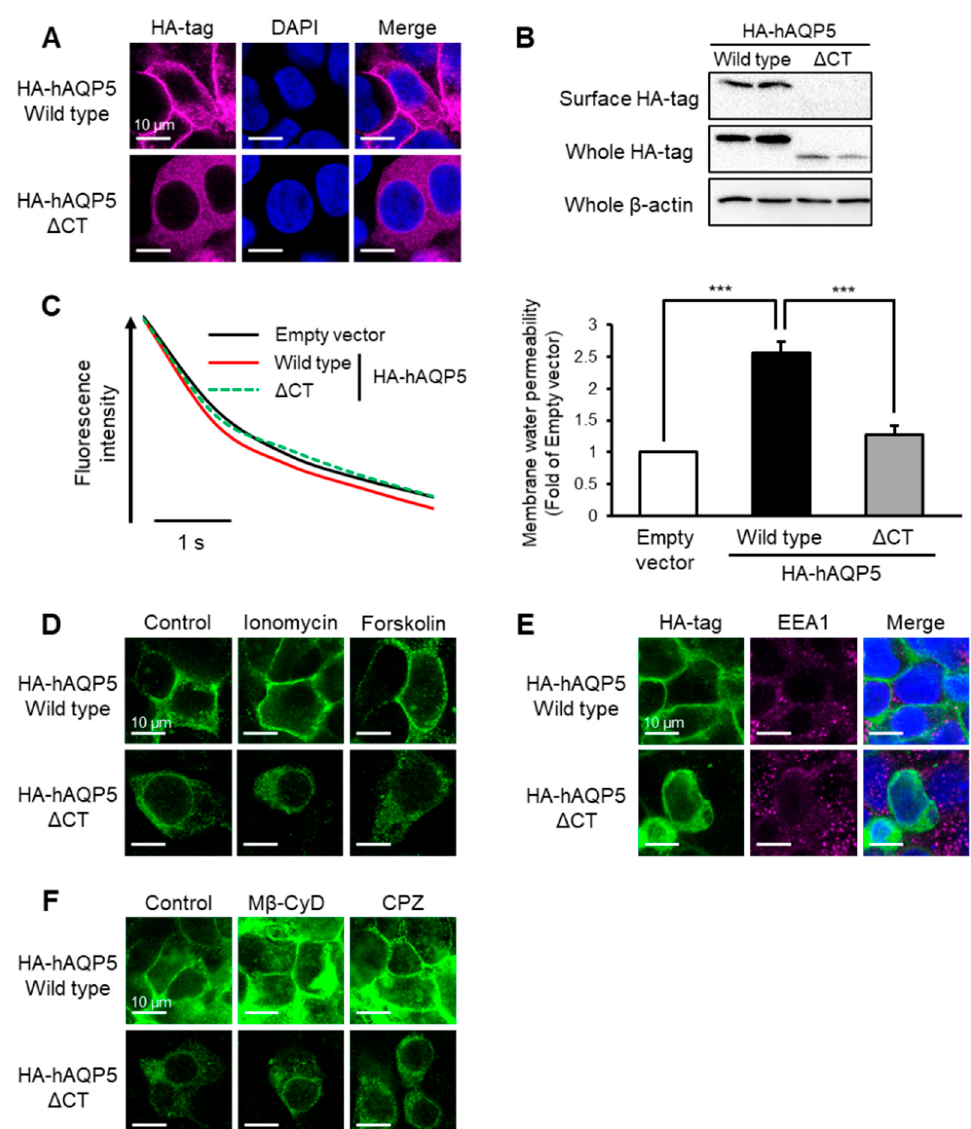
Figure 1. C-terminal domain is required for plasma membrane localization of AQP5. HEK-293 cells transfected with hAQP5- Δ CT were analyzed for the cellular localization of the mutants by immunofluorescence ( A ) and assessed for the level of cell surface mutants by cell surface biotinylation and Western blotting ( B ). Membrane water permeability of CHO-K1 cells transfected with hAQP5- Δ CT was measured using the calcein quenching method at 37 °C. Each data point represents mean ± SE ( n = 3), *** p < 0.001 ( C ). HEK-293 cells transfected with hAQP5- Δ CT were treated with ionomycin (1 µM) or forskolin (10 µM) for 15 min. The cellular localization of the mutants was analyzed by immunofluorescence ( D ). HEK-293 cells transfected with hAQP5- Δ CT were analyzed for the cellular localization of the mutants and EEA1 by immunofluorescence ( E ). HEK-293 cells transfected with hAQP5- Δ CT were treated with methyl- β -cyclodextrin (M β -CyD, 1 mM) or chlorpromazine (CPZ, 10 µg/mL) for 12 h. The cellular localization of the mutants was analyzed by immunofluorescence ( F ). Typical data in triplicated experiments are shown.